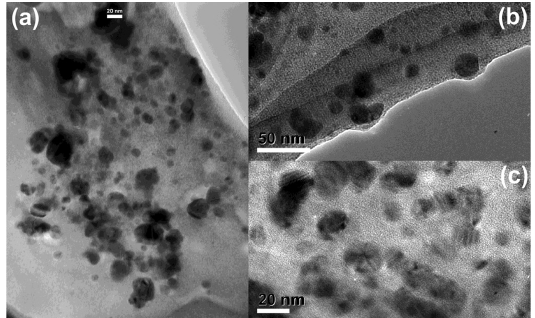
Figure 7. Representative (a) TEM and (b,c) HR-TEM images of our dried solutions for different magnifications. In this case, micrographs correspond to a Sol-9505 precursor.